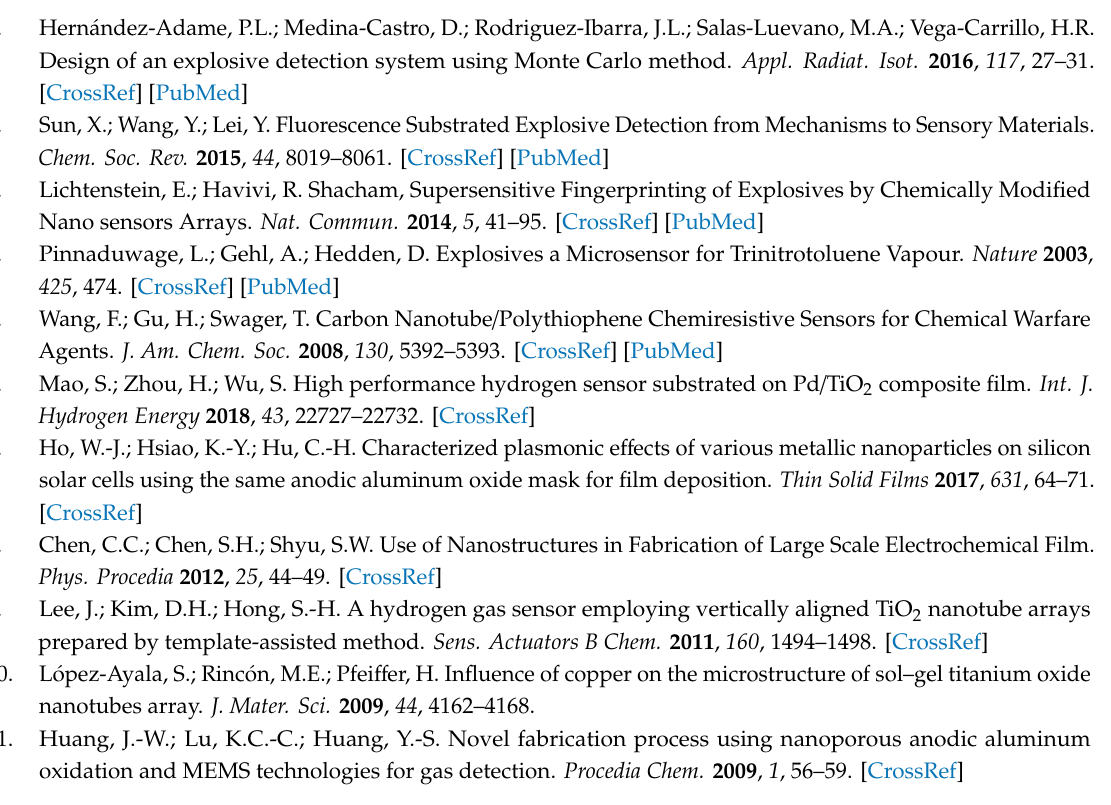
Table S1: The available techniques for detection of